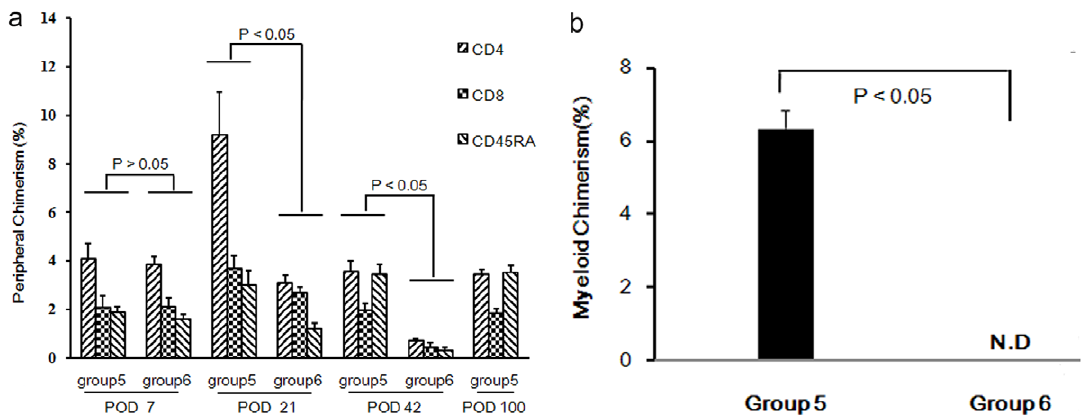
Figure 3. Dynamic changes of peripheral chimerism. Flow cytometry analysis for the presence of donor-specific CD4 + /CD8 + T lymphocytes and CD45RA + B lymphocytes at POD 7, POD 21, and POD 42 of one representative intact allogeneic hind limb recipient with CsA treatment. Levels of donor-specific chimerism were 3.3% in CD4/RT1 n cells, 1.2% in CD8/RT1 n cells, and 1.6% in CD45RA/RT1 n cells at POD 7. They rose to the highest level for donor-origin CD4/RT1 n 13.2%, CD8/RT1 n 2.9%, and CD45RA/RT1 n 2.1% at POD 21, remained at 3.6% CD4/RT1 n , 2.0% CD8/RT1 n , and 3.0% CD45RA/ RT1 n . The background levels observed in isograft controls were assessed at 0.3%, 0.2%, and 0.3%, respectively.